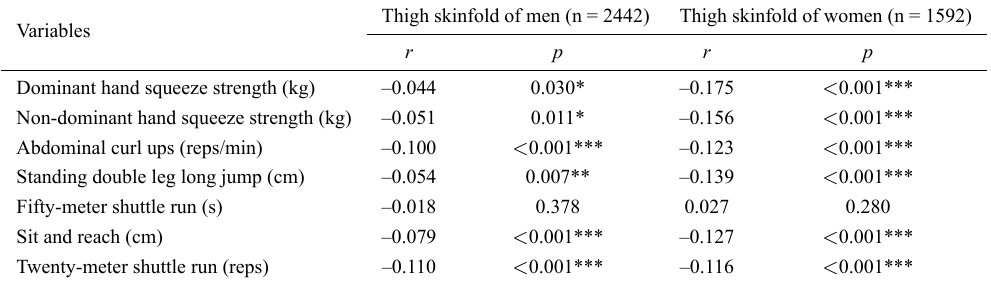
Table 4. Correlationships between thigh skinfold and physical fitness in adults (aged 19–64 years). Variables